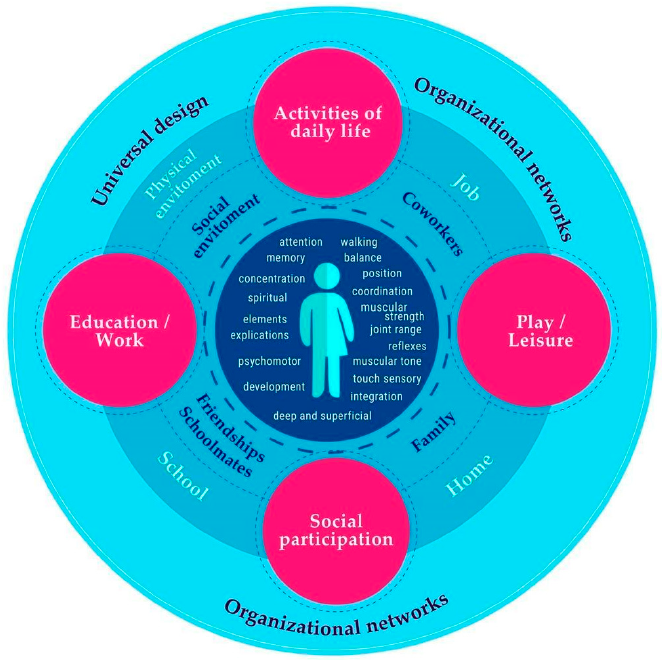
Figure 5. A community approach to neurorehabilitation. This figure represents the levels of ap- proach and practical competencies of community occupational therapy intervention in neuroreha- bilitation, focusing on daily life occupations, study/work, play and leisure time, as well as social participation. It addresses elements at the personal level, represented by green, and in the biological, psychological, and spiritual dimensions and at the micro-level, represented by the color light blue. At the macro level, the color apricot highlights aspects of accessibility, community, and organiza- tional